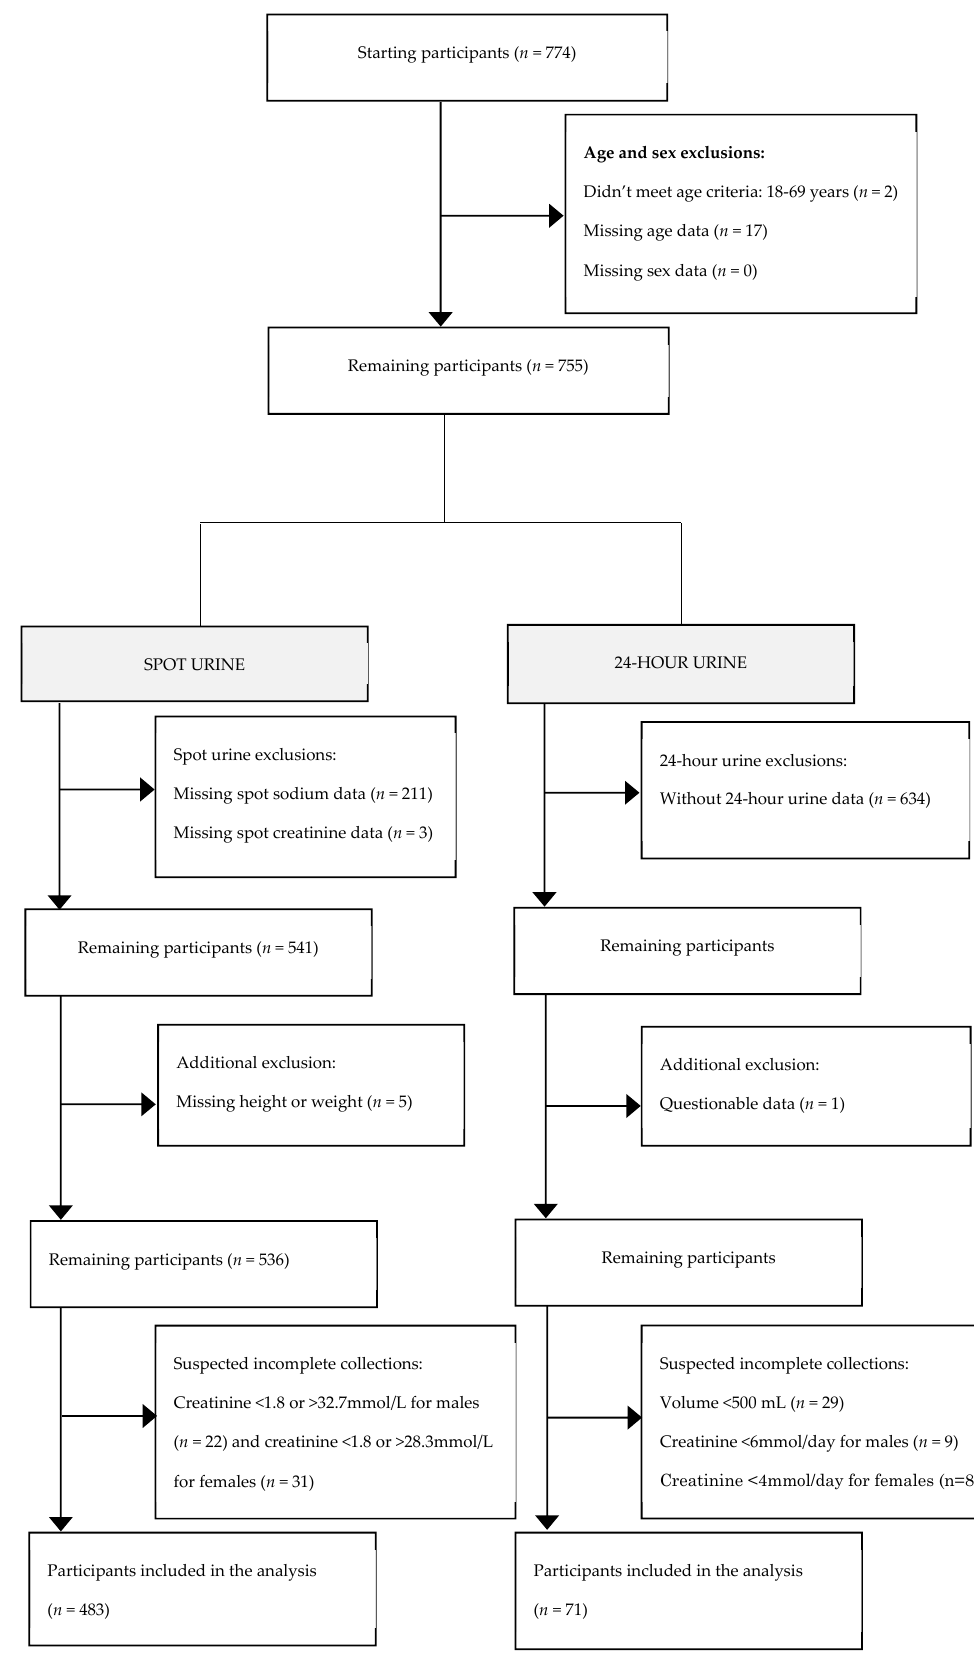
Figure 1. Process of determining the final participant number.